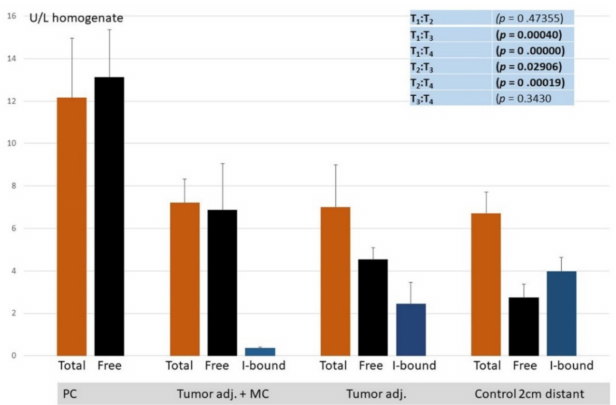
Figure 3. Total, free, and inhibitor-bound (latent) Poly(A) deadenylaseactivity(U/L) in PC, tumor adjacent with MC, tumor-adjacent, and control healthy counterparts.